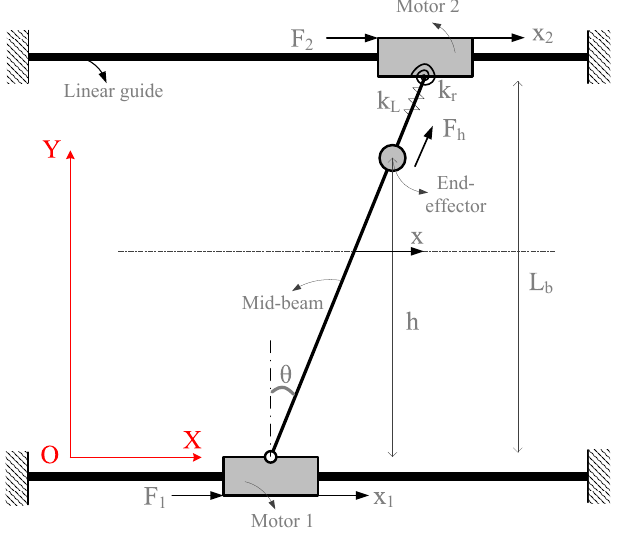
Figure 2. Structure of the investigated